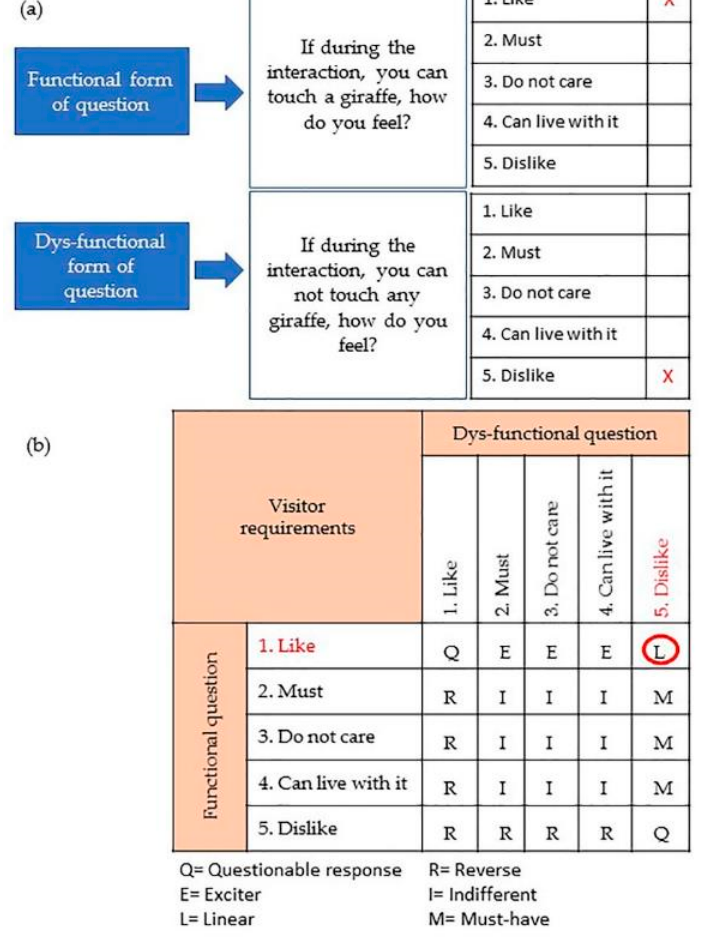
Figure A1. Kano Analysis ( a ) questionnaire format and ( b ) evaluation table for the classification of the results. Two red crosses indicated the hypothetical answers of a respondent in the questionnaire and a red circle mark the successive classification. Table A1. Details of the multi-facetted animal welfare assessment used in the pilot study (step A–C1).